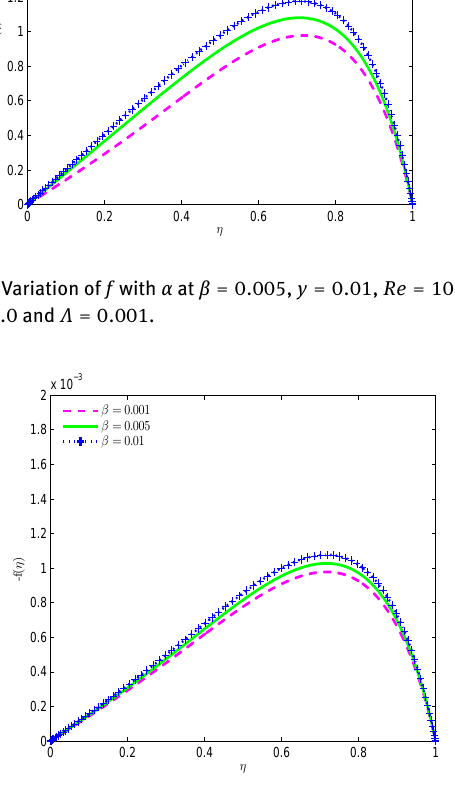
Fig. 11: Variation of f with Re at α = 0.01 , β = 0.005 , γ = 0.01 , K = 10.0 and Λ = 0.001 .